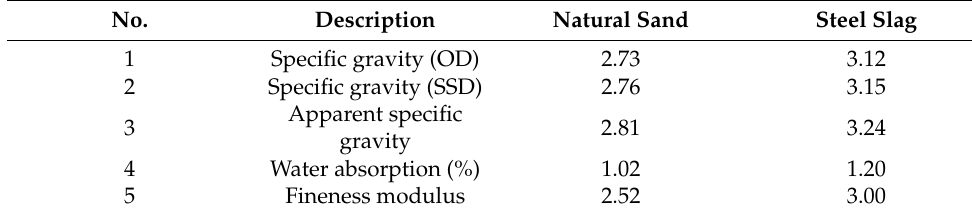
Table 2. Physical properties of natural sand and steel slag.